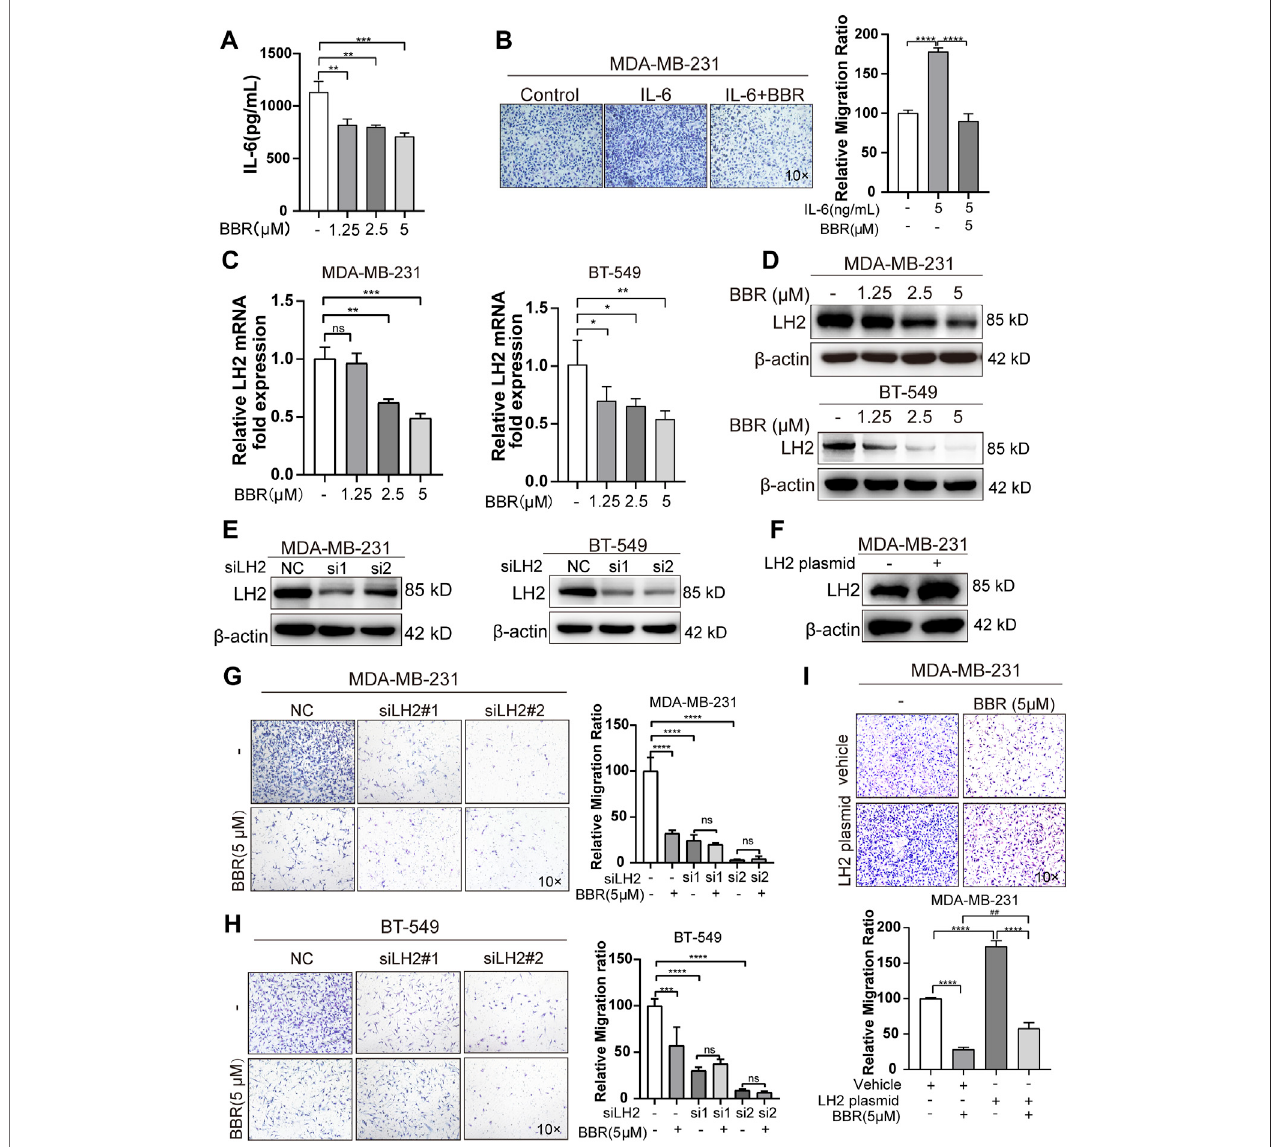
FIGURE4| Berberineinhibits the migration ofTNBC cellsin aLH2-dependent manner. (A – B) .The secretion ofIL-6 wasdetected byusing theIL-6 Elisakit. MDA- MB-231 cells were cultured with or without berberine (1.25, 2.5 and 5 μ M) for 48 h, then the supernatant medium was collected for the detection of IL-6 levels. (B) Recombination human IL-6 protein (5 ng/ml) was used to stimulate MDA-MB-231 cells for 6 h, and berberine (5 μ M) was used to treat MDA-MB-231 cells for 48 h, following which the cells were collected for transwell assay for 12 h. (C – D) LH2 mRNA and protein expression in the MDA-MB-231 and BT-549 cells in the presence of berberine (1.25, 2.5, 5 μ M) were measured by q-RT-PCR and Western blot analysis. (E) Silencing of LH2 and validated the knockdown ef fi ciency at protein levels. (F) Overexpression of LH2 and validated the ef fi ciency at protein levels. (G – H) Representative images ofthe MDA-MB-231 or BT-549 cells treated with berberine (5 μ M) or not after LH2 silencing. (I) Representative images of the MDA-MB-231cells treated with berberine (5 μ M) or not after the LH2 overexpression. 10 × Scale bars, 200 μ m.Allresultswererepresentativeofthreeindependentexperiments.** p < 0.01,*** p < 0.001vs.control,nc,vehiclecellsorLH2overexpressioncells.### p < 0.001 vs. vehicle cells treated with